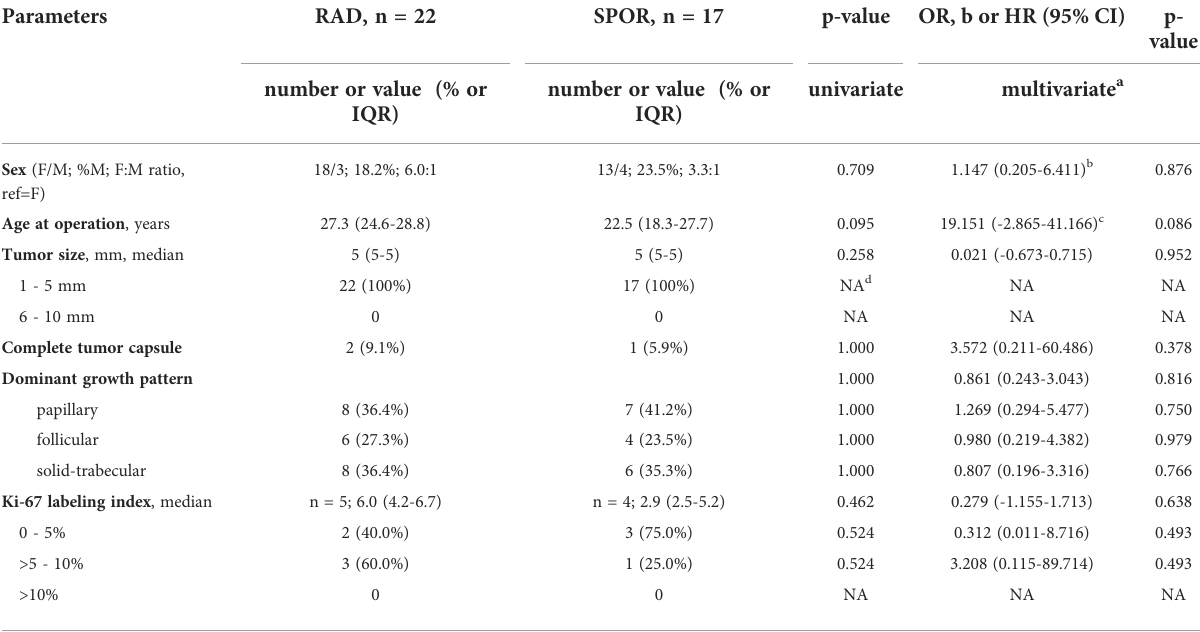
TABLE 4 Characteristics of the radiogenic and sporadic papillary thyroid microcarcinomas sized up to 5